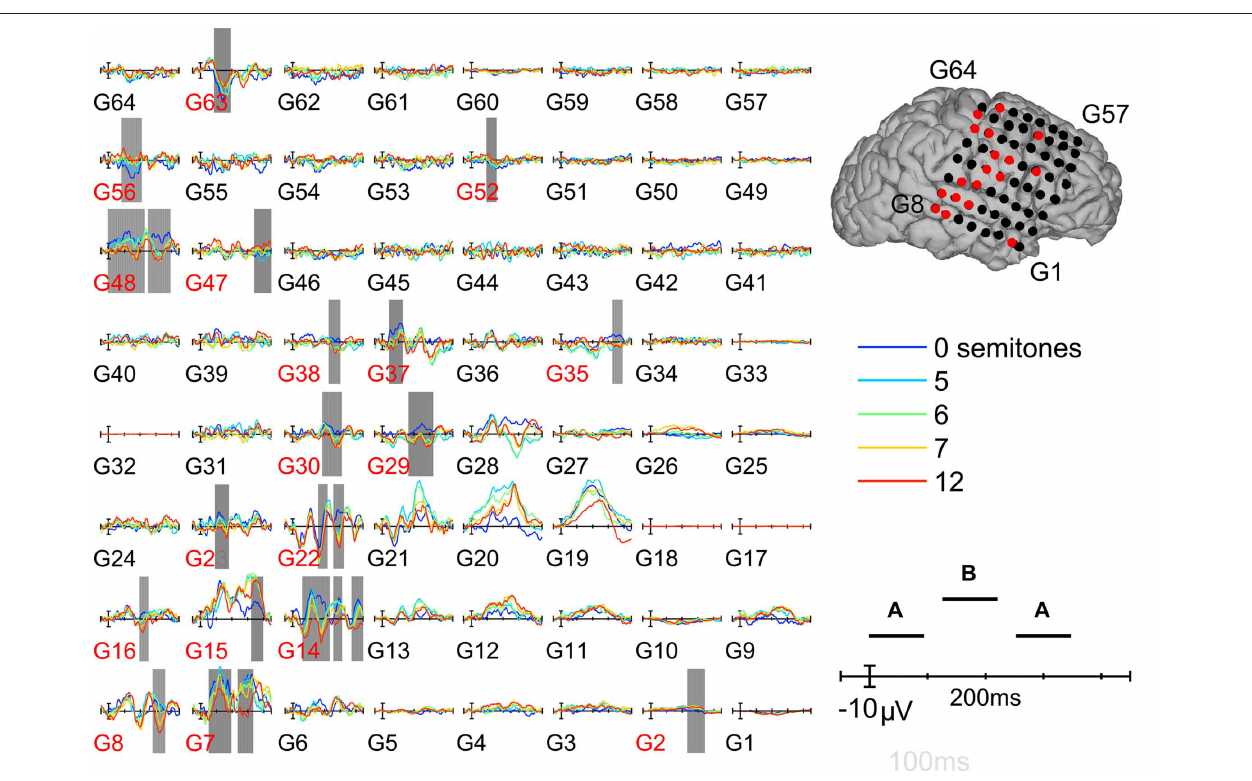
the acoustic parameter (frequency separation) and EP-amplitude are indicated by gray shading behind the waveforms. The responses showing significant correlations with frequency separation are also indicated by red text or dots underneath the waveforms or over the cortical surface, respectively.